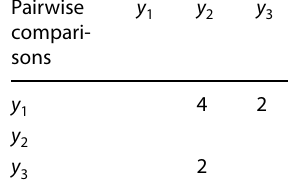
Pairwise compari-